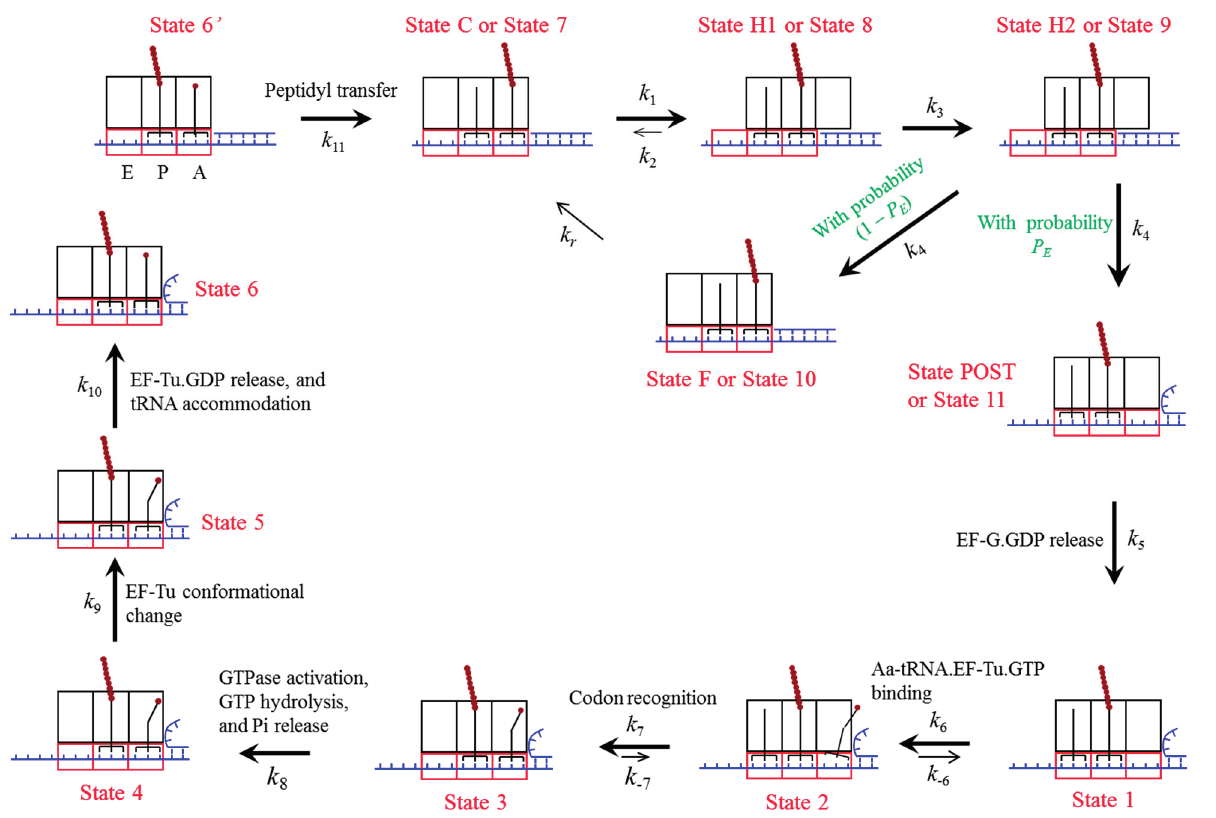
Figure 9. Pathway of the ribosome translation elongation through the mRNA duplex at saturating concentration of EF-G·GTP (see text for detailed description). The rate constant k 6 = k b [TC], where k b is the binding rate of the aminoacyl-tRNA·EF-Tu·GTP